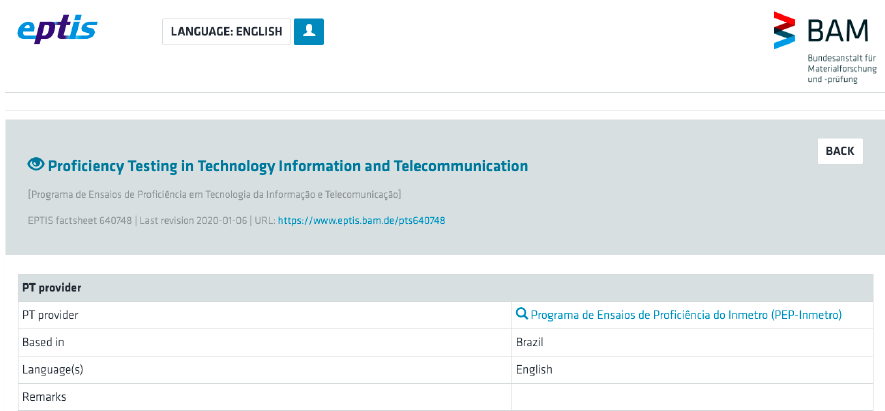
Figure 6. Registration of the proficiency testing in the EPTIS